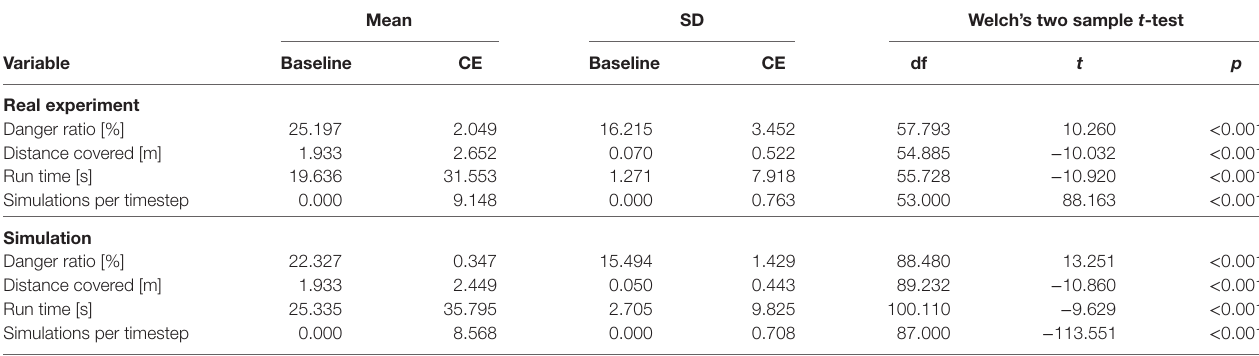
Details the results of the statistical analysis performed for Section 3 comparing baseline and CE experiments. Shown here are the results of Welch’s two sample t-test for all four metrics measured in the experiment comparing the performance of a robot using the CE to the baseline experiment. All variables show significant differences between CE and baseline for both real robots and